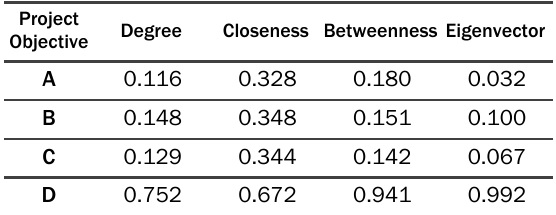
Table 4. Two-Mode Centrality Measures for 2011 Project